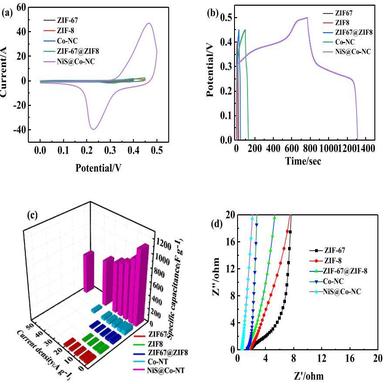
The electrochemical performances of electrodes of different materials in 6 M KOH solution: (a) CV curves at a scan rate of 20 mV⋅s − 1 ; (b) GCD curves at a current density of 1 A⋅g− 1 ; (c) The specific capacitance at different current densities; (d) The Nyquist curves in the frequency range of 0.01 Hz to100 kHz.